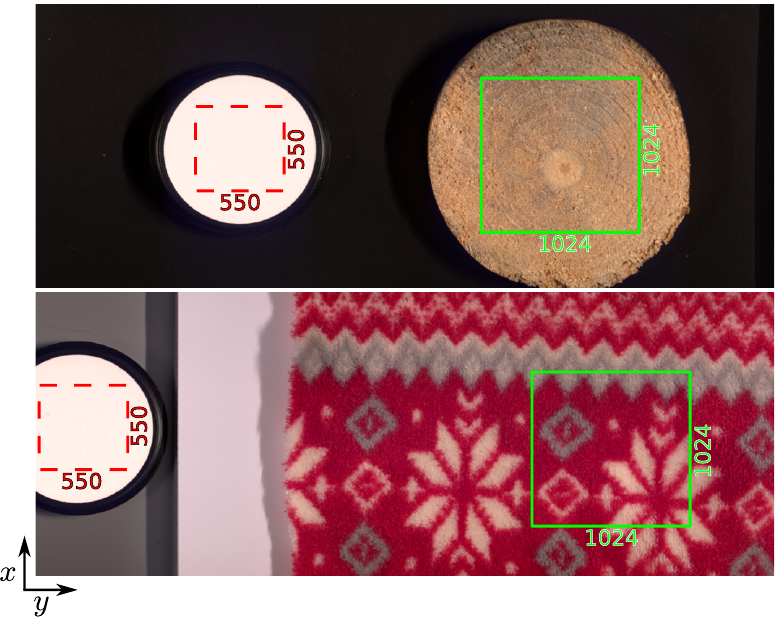
Figure 5. sRGB rendering of two corrected radiance images. The subimage (red dashed square) inside the SG-3051 reflectance tile is selected for illumination estimation and the texture region (green solid square) is retained as final reflectance image